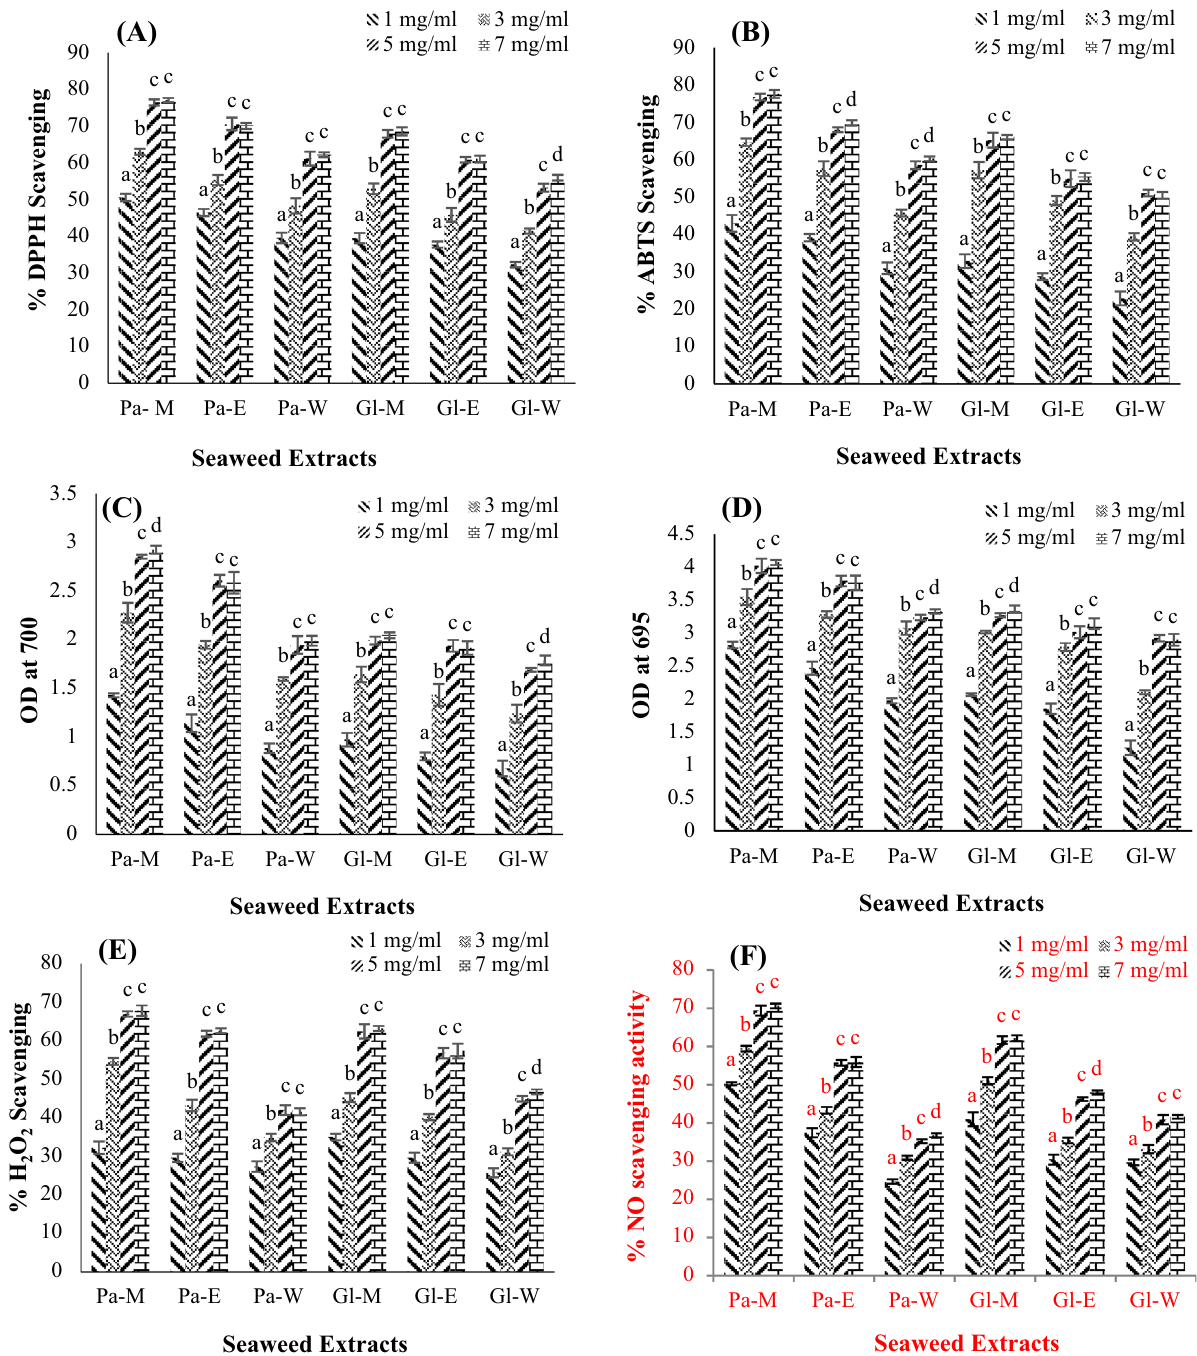
Figure 2. ( A ) 1, 1-diphenyl-2-picrylhydrazyl assay, ( B ) 2, 2-azino-bis (3-ethylbenzothiazoline-6-sulfonic acid) assay, ( C ) Reducing power assay, ( D ) Phosphomolybdenum assay, ( E ) Hydrogen peroxide scavenging assay, (F) NO scavenging assay of different crude extracts of P. tetrastromatica and G. tenuistipitata . Pa— Padina tetrastromatica , Gl— Gracilaria tenuistipitata , M—methanol, E—ethanol,